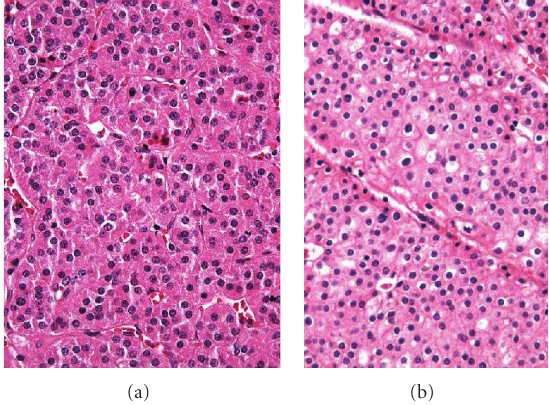
Figure 3: (a) Oncocitomas, (b) eosinophilic chromophobe renal cell carcinoma variant. Notice the similar aspect that both lesions can present.